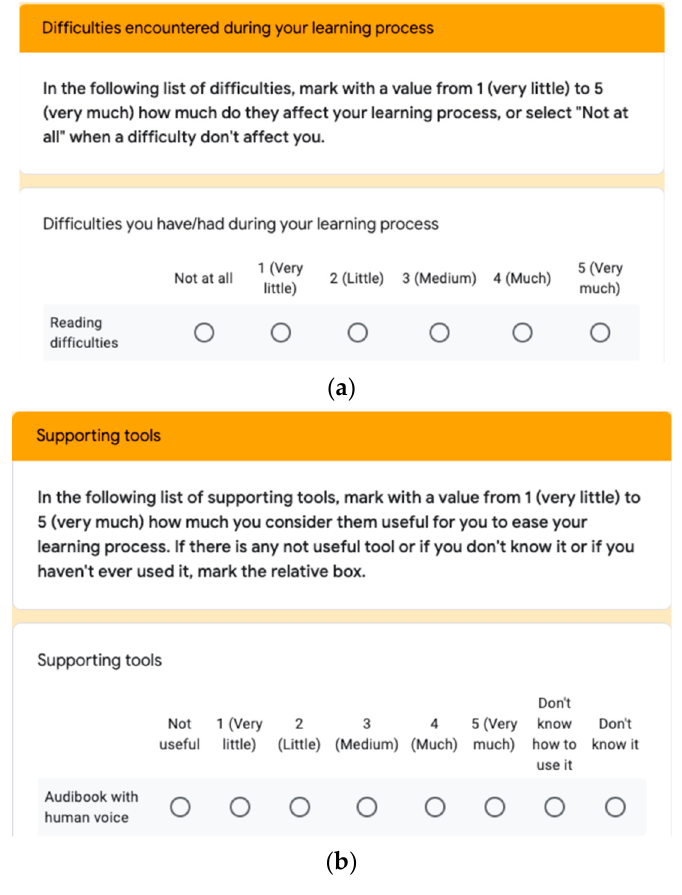
Figure 7. Example of two inquiries of the questionnaire, about the issues experienced ( a ) and the supporting methodologies considered as useful ( b ) by dyslexic students.